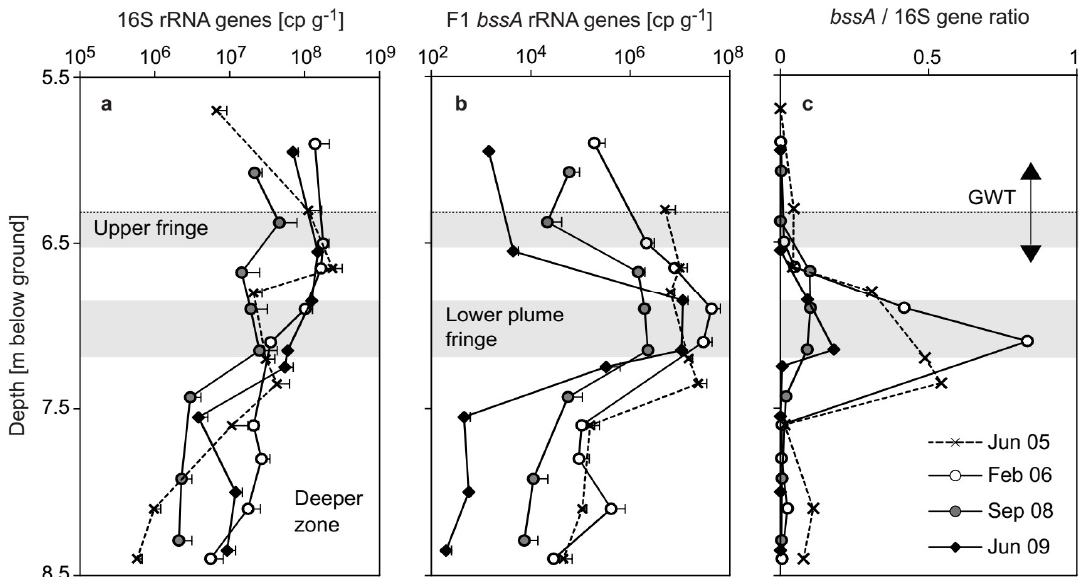
Figure 3. Depth profiles of sedimentary bacterial rRNA genes and anaerobic toluene degradation genes at the Flingern aquifer during the study. ( a ) Total bacterial 16S rRNA genes and ( b ), ‘F1-cluster’ bssA genes [12,35] as quantified via qPCR of triplicate sediment DNA extracts. Shown are average gene counts g − 1 sediment plus standard error (positive only). ( c ) Relative bssA gene abundance within total gene counts. Data from June 2005 were already reported previously [12]. Further details are as in Figure 2.